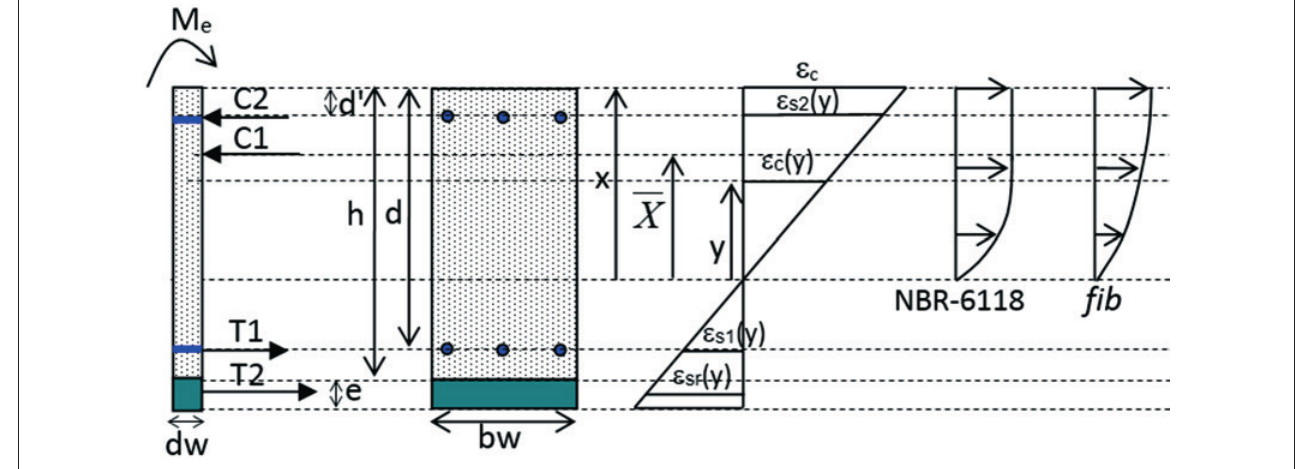
Figure 2 – Features of transversal rectangular cross section. Representation of the acting forces on a cross section with a differential thickness dz and the stress-deformation diagrams by NBR-6118 and